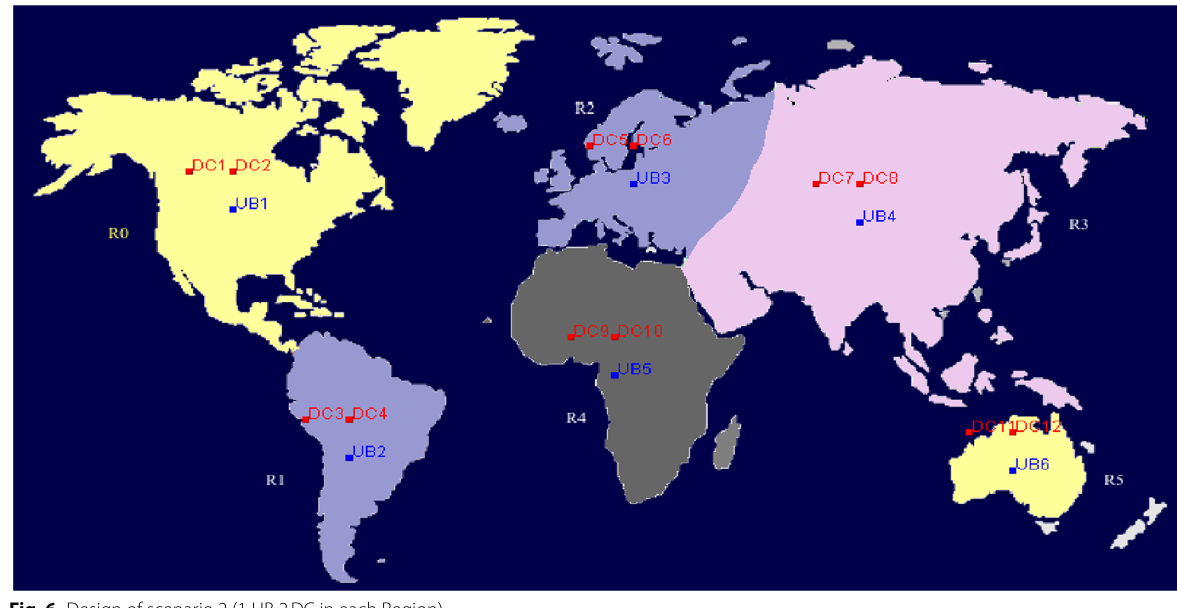
Fig. 6 Design of scenario 2 (1 UB 2 DC in each Region)